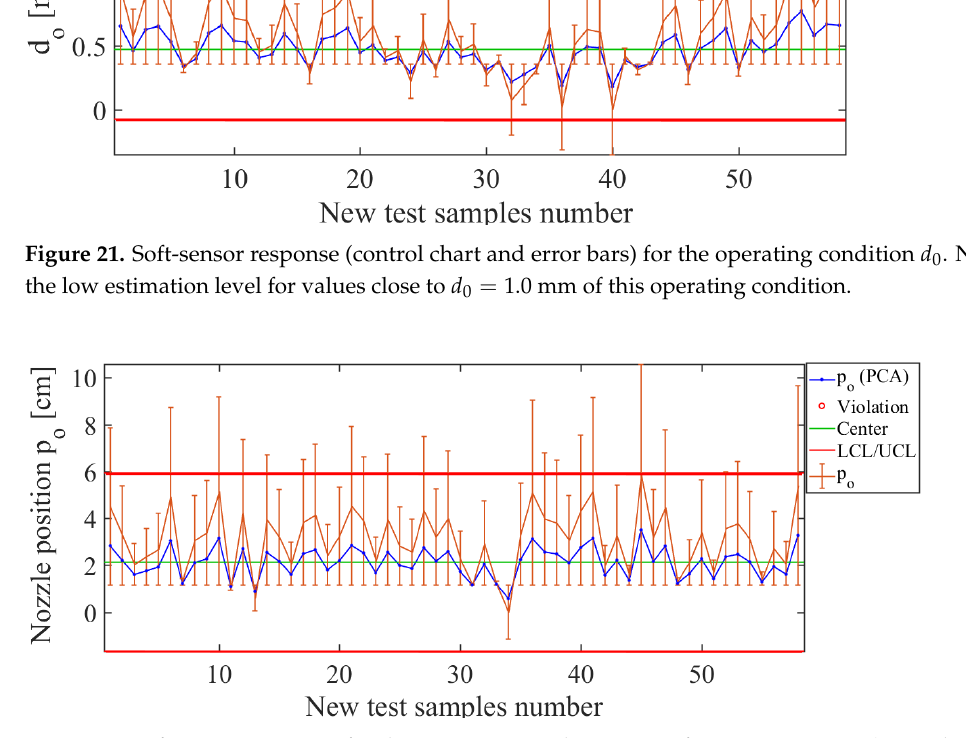
Figure 22. Soft-sensor response for the operating condition p 0 . Soft-sensor response (control chart and error bars) for the operating condition p 0 . Note the low estimation level for values greater than p 0 = 6 cm.